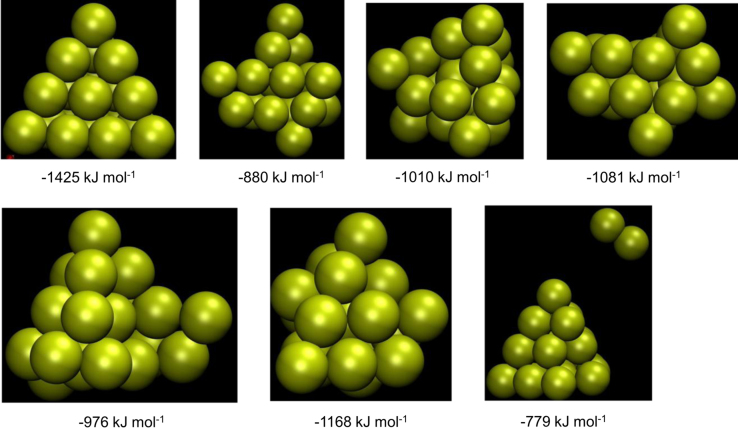
Representative stable structures of Au20 and corresponding formation energies.